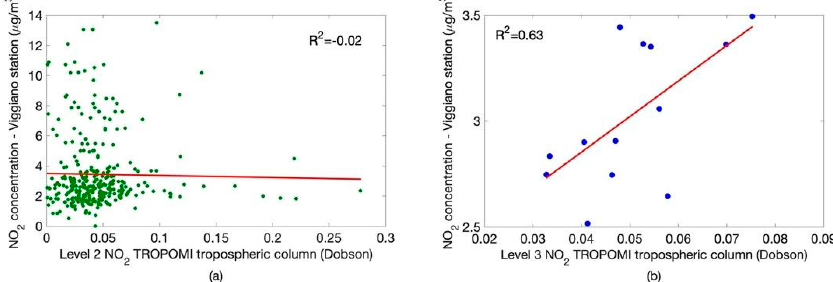
Figure 11. Scatter plot of NO 2 observations for the Viggiano station. Before ( a ) and after ( b ) kriging. The analysis refers to the period of May 2018 – May 2019.